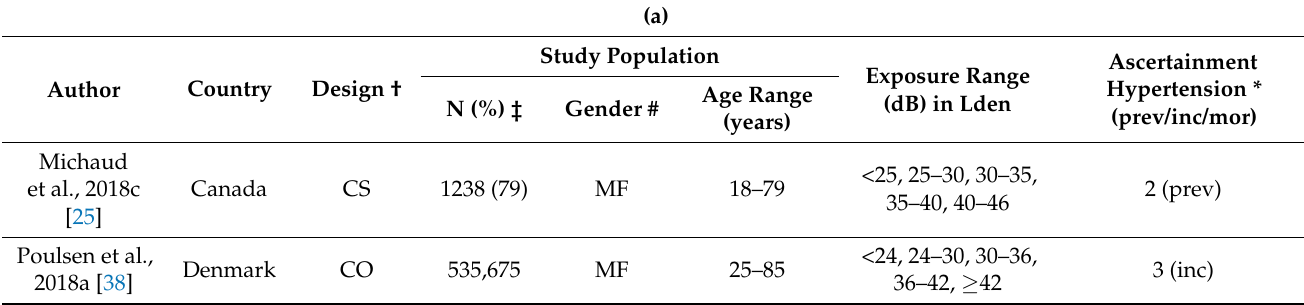
Table 4. ( a ) Overview of the characteristics of the selected studies on the association between WT sound and hypertension. ( b ) Overview of the characteristics of the selected studies on the association between WT sound and ischemic heart